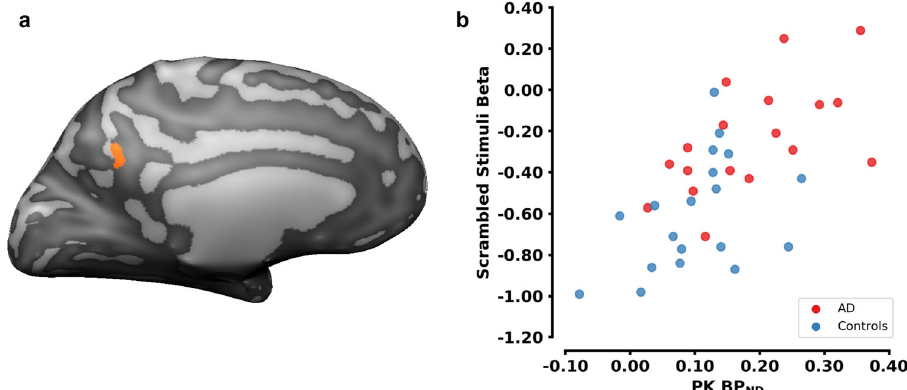
Fig. 3 The interplay between neuroin fl ammation with the BOLD response at a task-driven functionally de fi ned PCC cluster. a PCC cluster (left hemisphere; center of mass in TAL space: − 9.70, − 55.44, 26.77; center of mass in MNI space: − 9.16, − 54.27, 31.2) extracted from the functional contrast [scrambled AD > scrambled controls ]. b Relationship between the extension of neuroin fl amation at the PCC cluster, quanti fi ed by the 11 C-PK11195 BP ND , and the scrambled stimulus betas on that region. Higher betas express higher